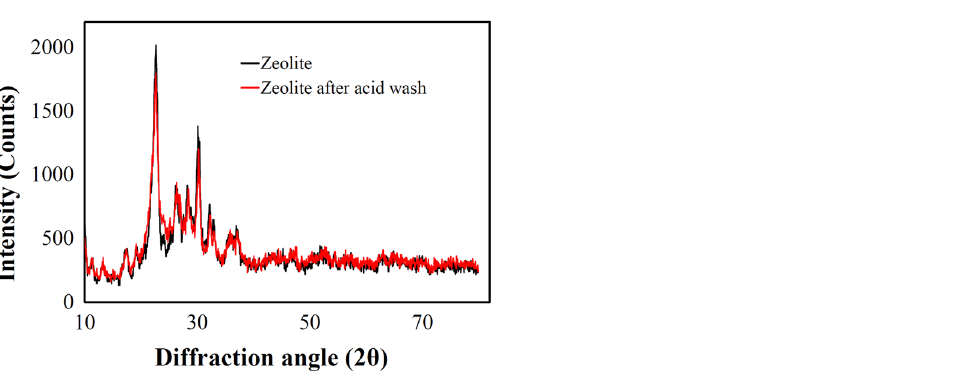
Figure 2. XRD analysis of clinoptilolite zeolite before and after acidic